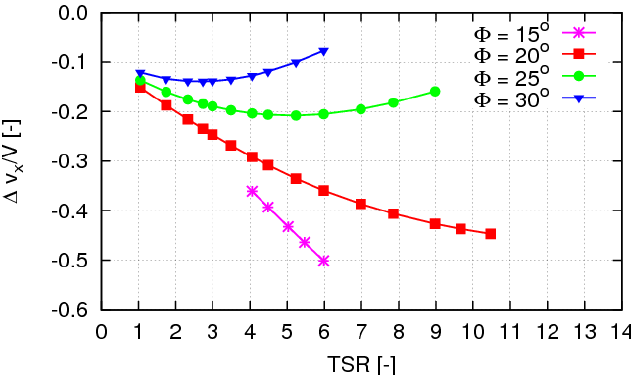
Figure 16. UoS-VP turbine. Axial induced velocity distribution at axial position corresponding to blade trailing edge and 70% of blade span. Different pitch settings Φ